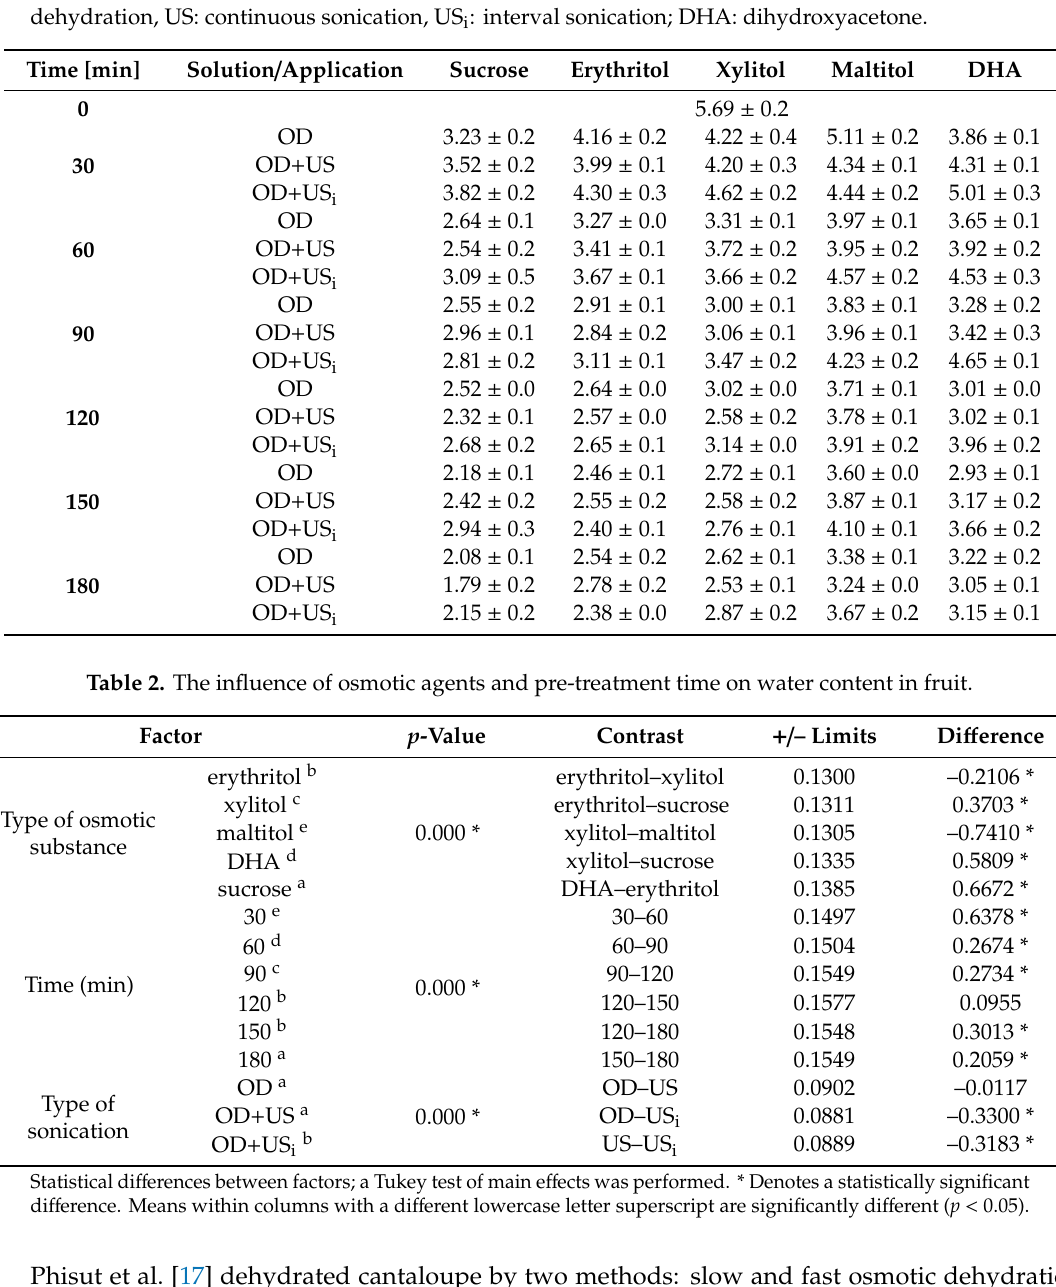
Table 1. Water content (g H 2 O / g dry matter) in apples during OD in di ff erent solutions. OD: osmotic